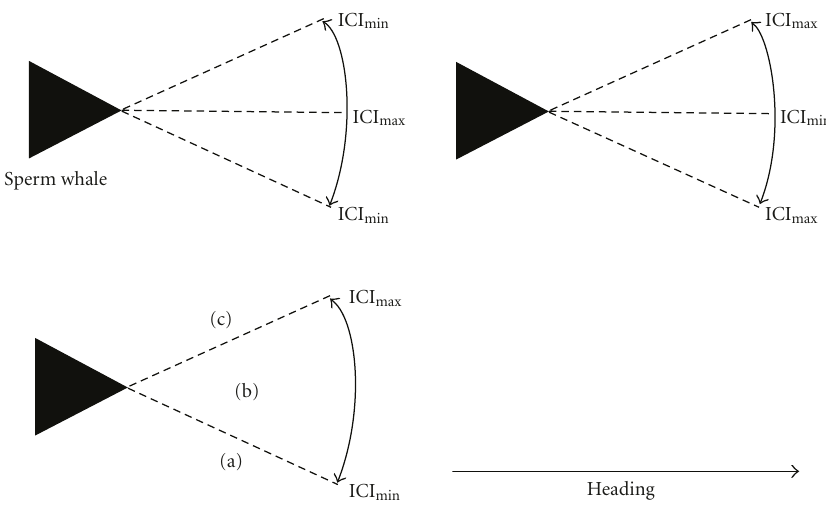
Figure 7: Three models describing the fast, periodic movement of the whale in sync with its ICI. Only the third model could lead to the synchronization ICI max ⇔ amplitude maximum using a hydrophone located either in front of or behind the whale (it is located in (a), on the right of the whale). The click apparent level and the ICI are in sync (ICI max ⇔ Energy of the whale). There is no apparent synchronization between the ICI, the o ff -axis angle, and the click energy if the hydrophone is in sector (b) (straight). The figure is from